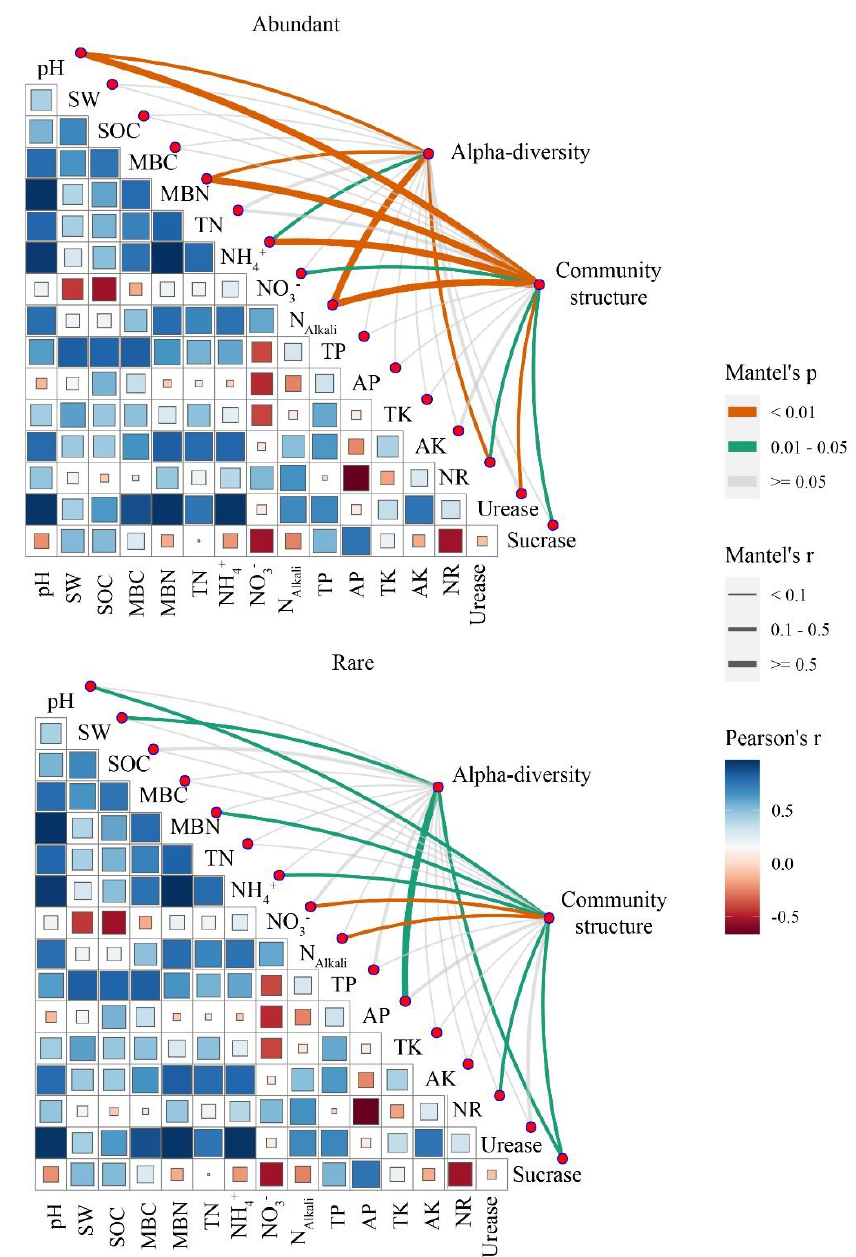
Figure 5. Partial Mantel correlation test between the soil physicochemical properties and bacterial α − diversity and composition for abundant and rare bacterial taxa. Community diversity includes OTU richness, the Shannon index, and the Pilou index. Community structure was expressed as PC1 and PC2 of the PCoA results of abundant and rare bacterial taxa. The width of the edges represents the R 2 of the Mantel test. The colors represent the p − values, which were based on 999 permutation tests. SW: soil water content; MBC: microbial biomass carbon; MBN: microbial biomass nitrogen;